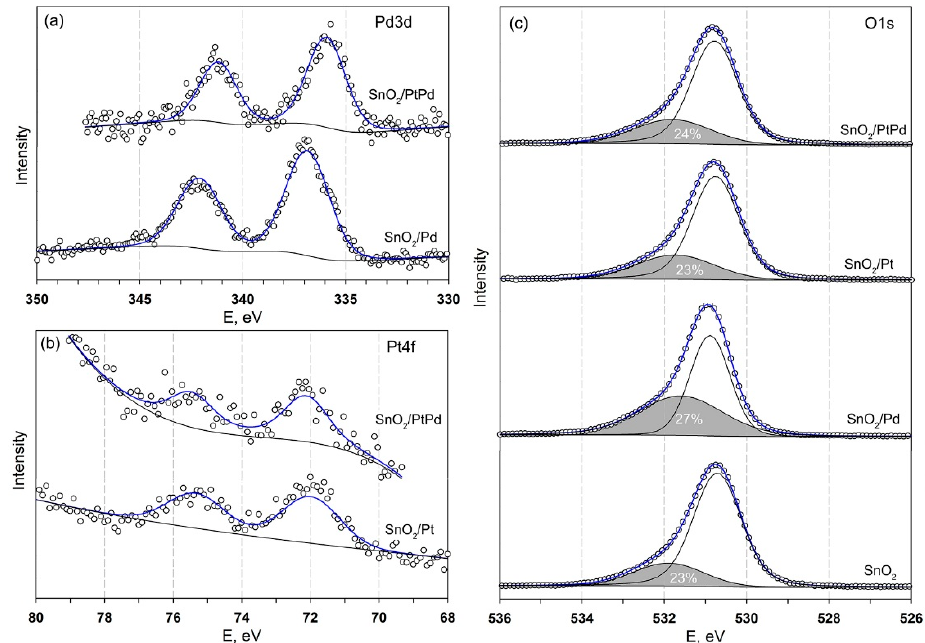
Figure 8. XP spectra Pd3d, ( a ) Pt4f, ( b ) O1s ( c ) of the samples.